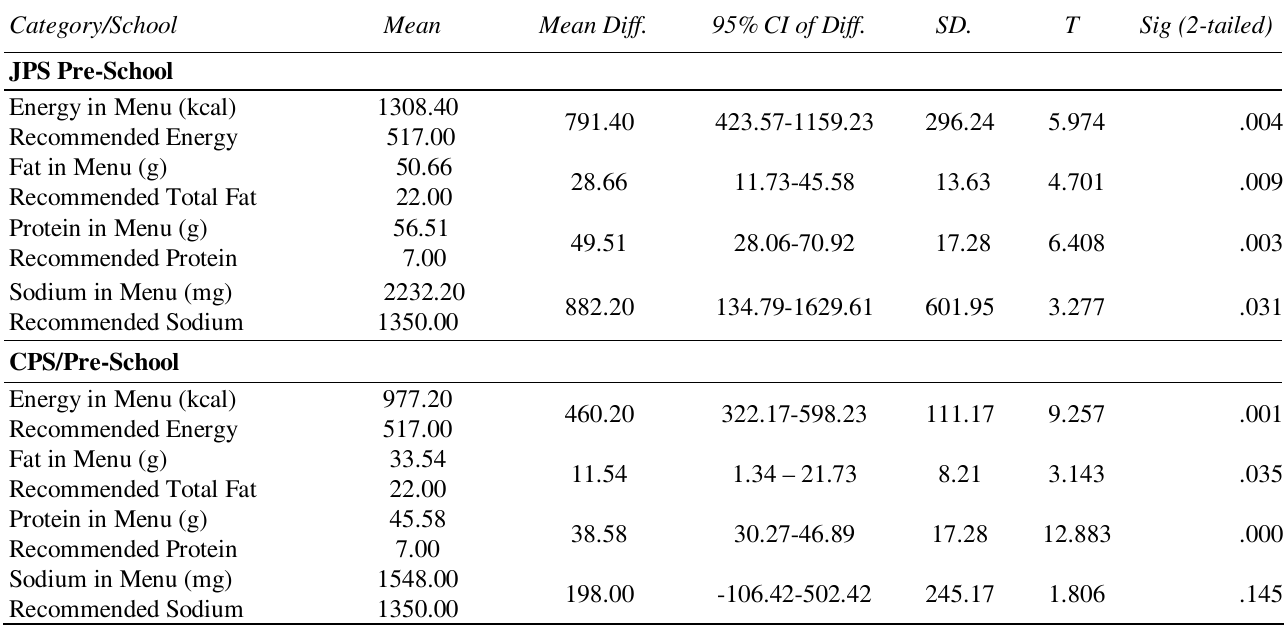
Table 8: Differences between nutrients in the regular menu and the recommended intake of nutrients for pre-school children